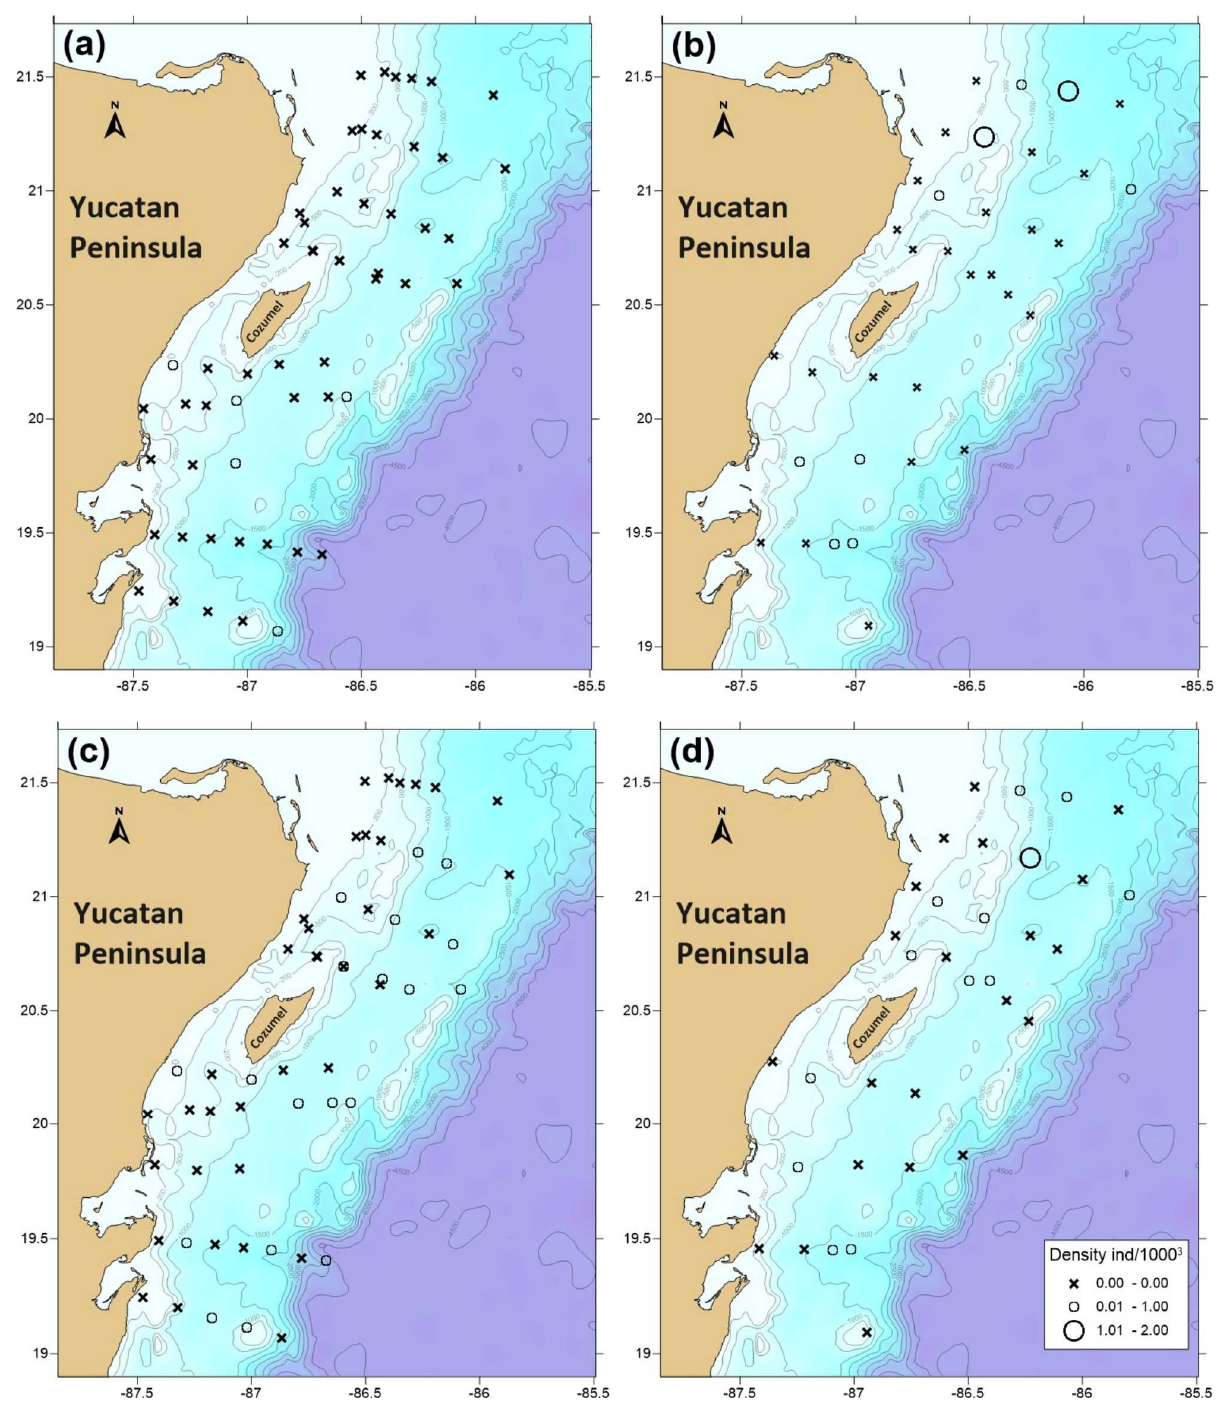
Figure 7. Density (number of larvae per 1000 m 3 of water) of phyllosomata of Palinurellus gundlachi by sampling station. ( a ) mid-stage phyllosomata, autumn cruise; ( b ) mid-stage phyllosomata, spring cruise; ( c ) late-stage phyllosomata, autumn cruise; ( d ) late-stage phyllosomata, spring cruise. The scale is the same for all panels.